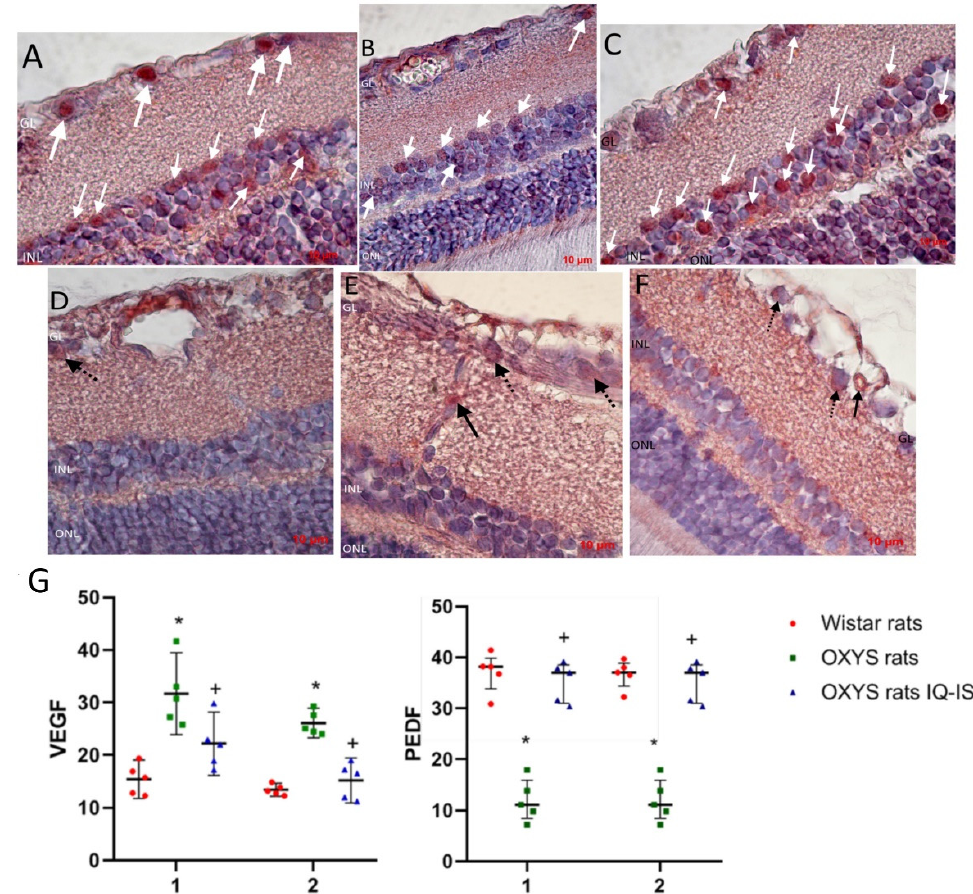
Figure 6. Detection and quantitative analysis of elements immunopositive to VEGF ( D – F ) and PEDF ( A – C ) in the retinas of Wistar rats ( A , D ), untreated OXYS rats ( B , E ), and IQ-1S-treated OXYS rats ( C , F ). Ganglionic neurons of the ganglionic layer (GL) and associative neurons of the inner nuclear layer (INL) were immunoreactive to PEDF in the neuroretina (white arrows). Vascular endothelium (black arrows) and ganglionic neurons (dashed arrows) were VEGF-immunopositive structures. IQ-1S treatment improved PEDF ( C ) and VEGF ( F ) expression in the retina of OXYS rats. Expression of VEGF in intraretinal vessels (1) and ganglion neurons (2) of Wistar rats, control rats, and OXYS rats treated with IQ-1S ( G ). The data are presented as the amount of VEGF- and PEDF-positive cells as a percentage of the total number of structures studied in the entire area of the retinal section (M ± SD).